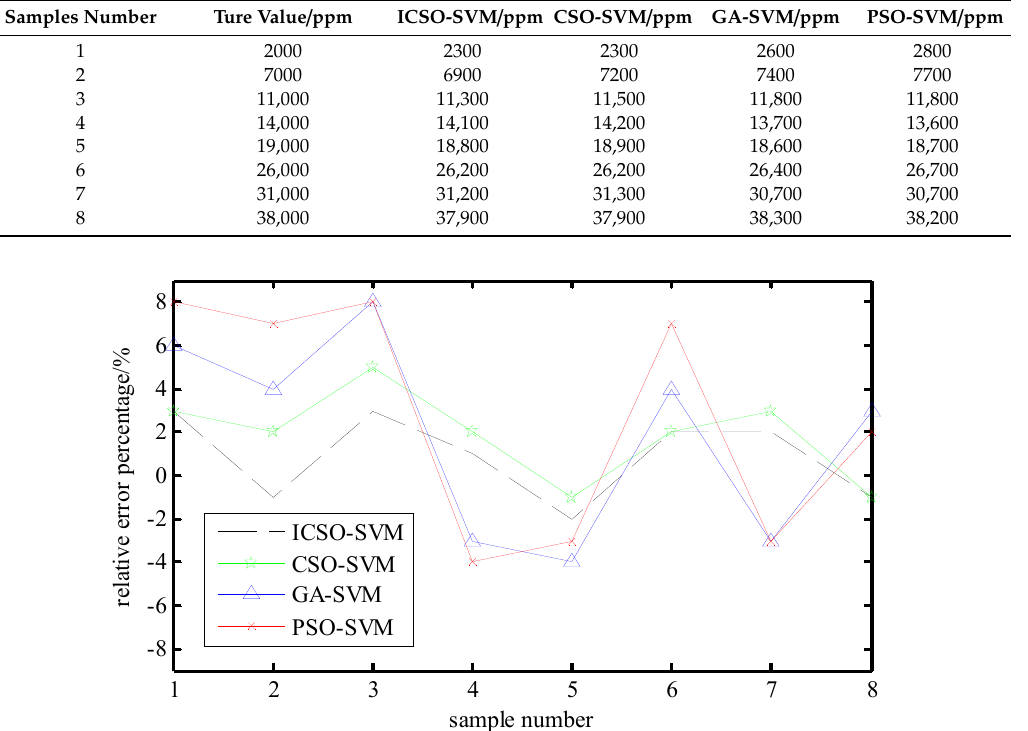
Figure 10. The relative error percentage for 8test samples.